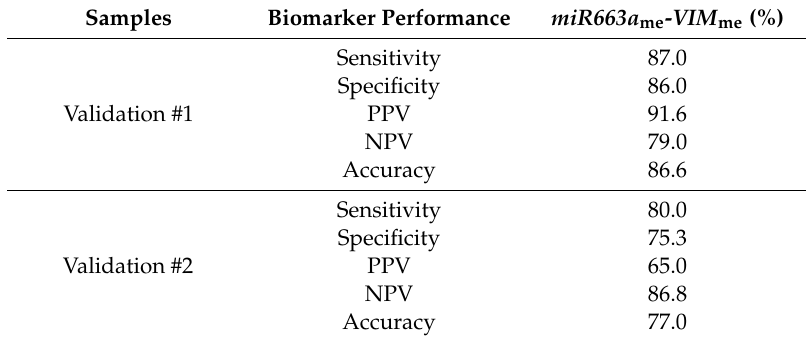
PPV—Positive Predictive Value; NPV—Negative Predictive